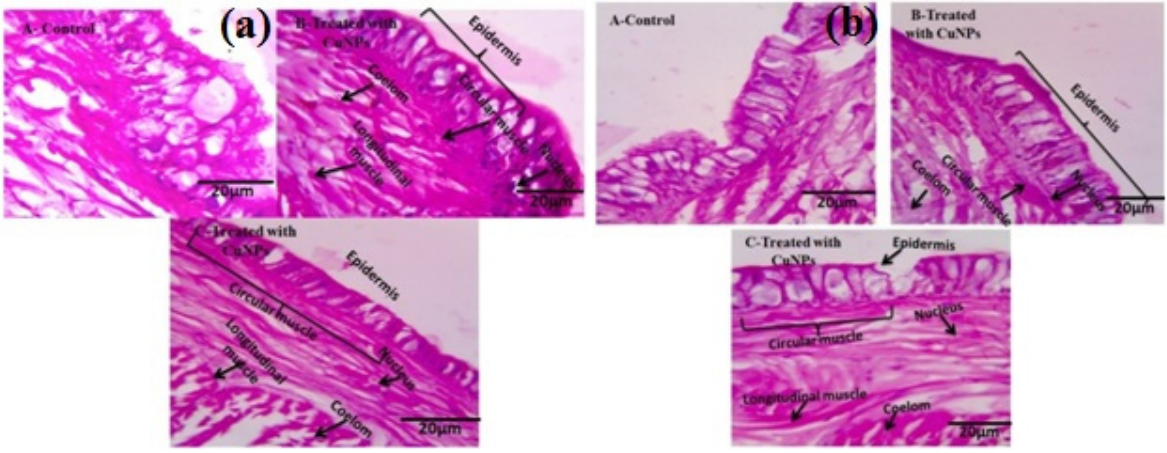
Figure 6. Histopathological studies of green copper nano-pesticide synthesized from M. robertsii against E. eugeniae and E. andrei : ( a ) E. eugeniae , ( b ) E. andrei with CuNPs at 24 h after treatment with CuNPs. Table 4. Non-target effect of green cluster copper nano-pesticide synthesized from entomopathogenic fungi M. robertsii against E. eugeniae and E. andrei at 30 days after treatment.